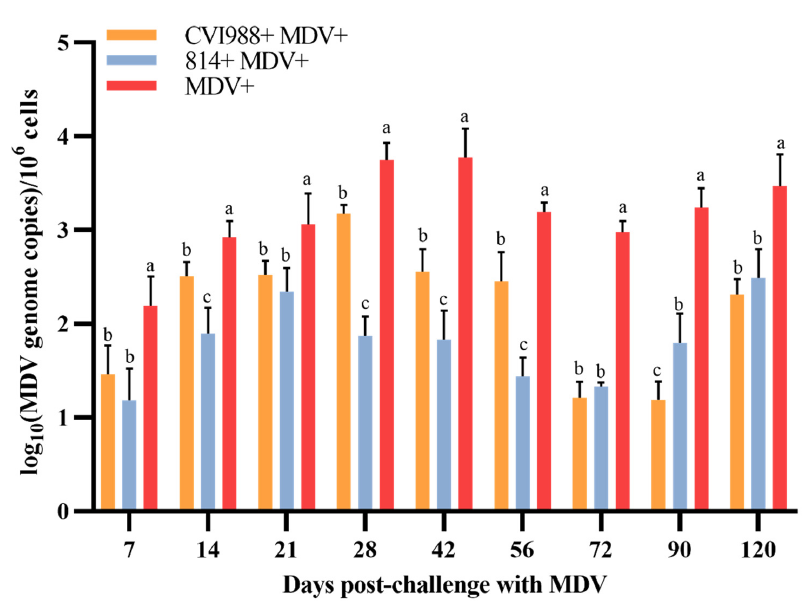
Figure 3. The viral load of MDV in the peripheral blood lymphocytes (PBLs) of the experimental birds. Means not sharing a common letter are significantly different ( p < 0.05).